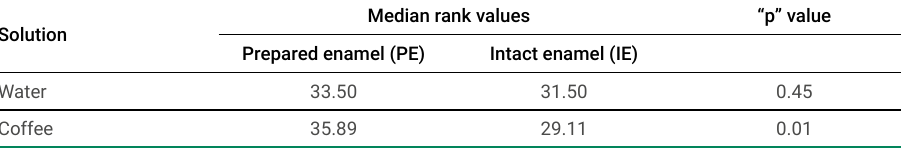
Table 2. Comparison between PE and IE in water and coffee solution - Mann-Whitney test Solution